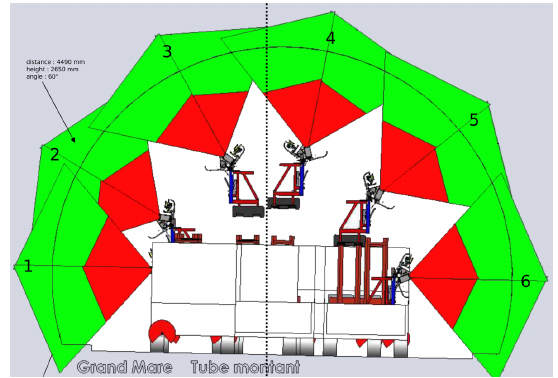
Figure 6. Distance, height and angle parameters pre-computed for every passage in a tunnel.